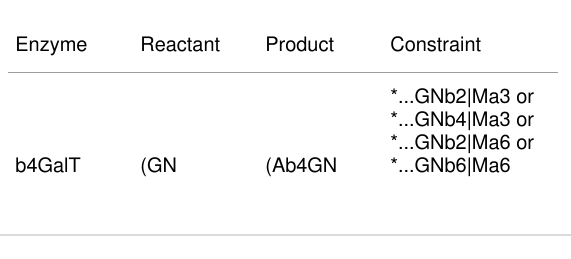
Table 7: The reaction rule (GN → (Ab4GN with four constraints written in the same cell.